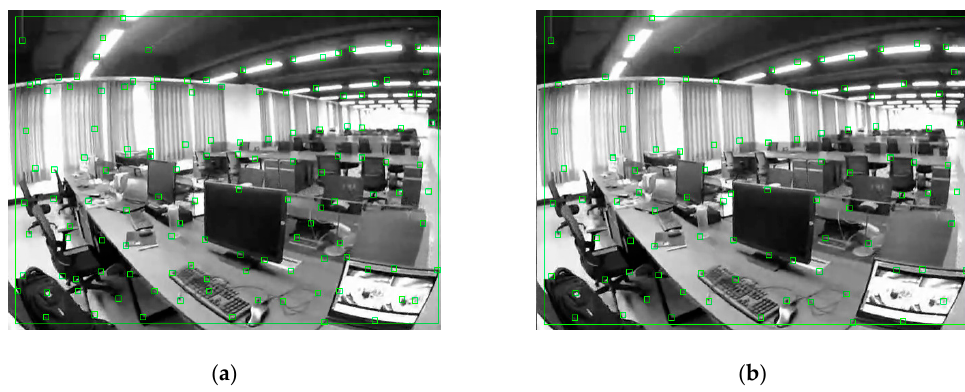
Figure 3. Feature points extraction in the grayscale image: ( a ) Original features from accelerated segment test (FAST) corner points distribution; ( b ) FAST corner points distribution after sparse processing.